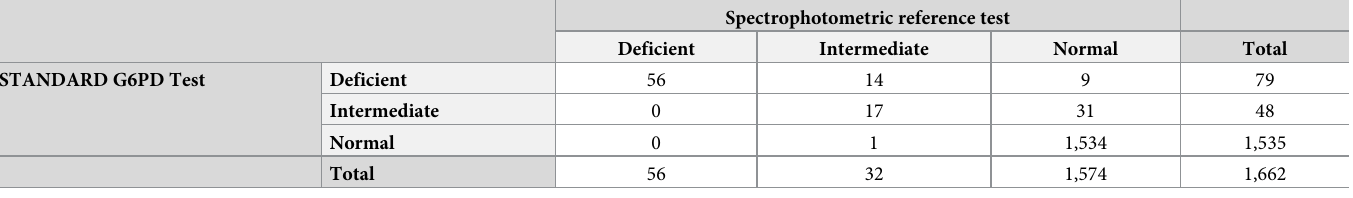
Table 6. Percent agreement between the STANDARD G6PD Test and the spectrophotometric reference test using the manufacturer’s threshold values at 30% and 70% G6PD activity thresholds, on venous specimens.